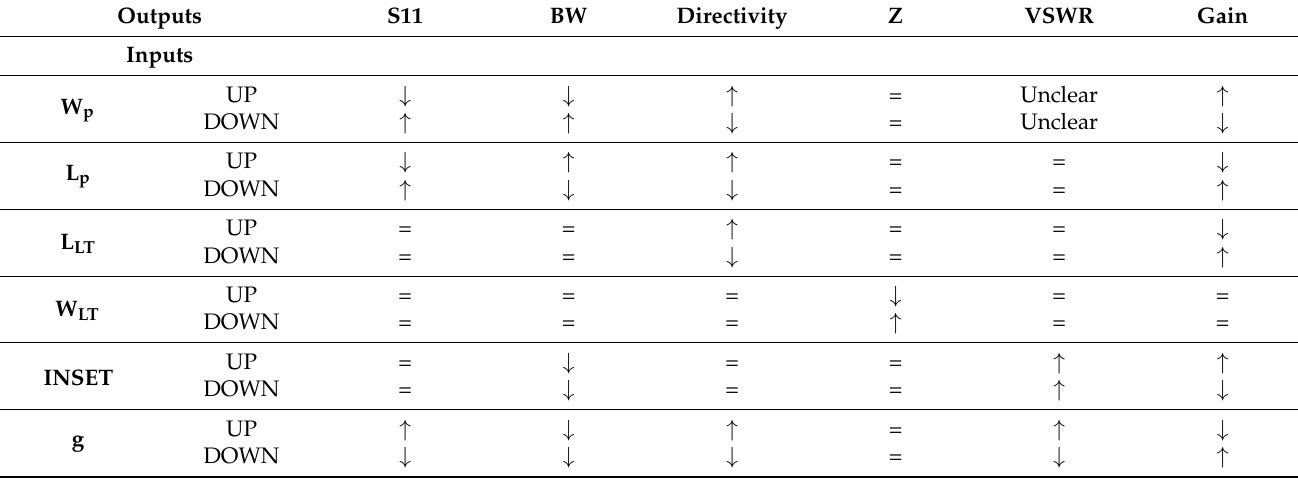
Table 7. Result of the study of simulating the InsetFeed antenna with different input parameters.